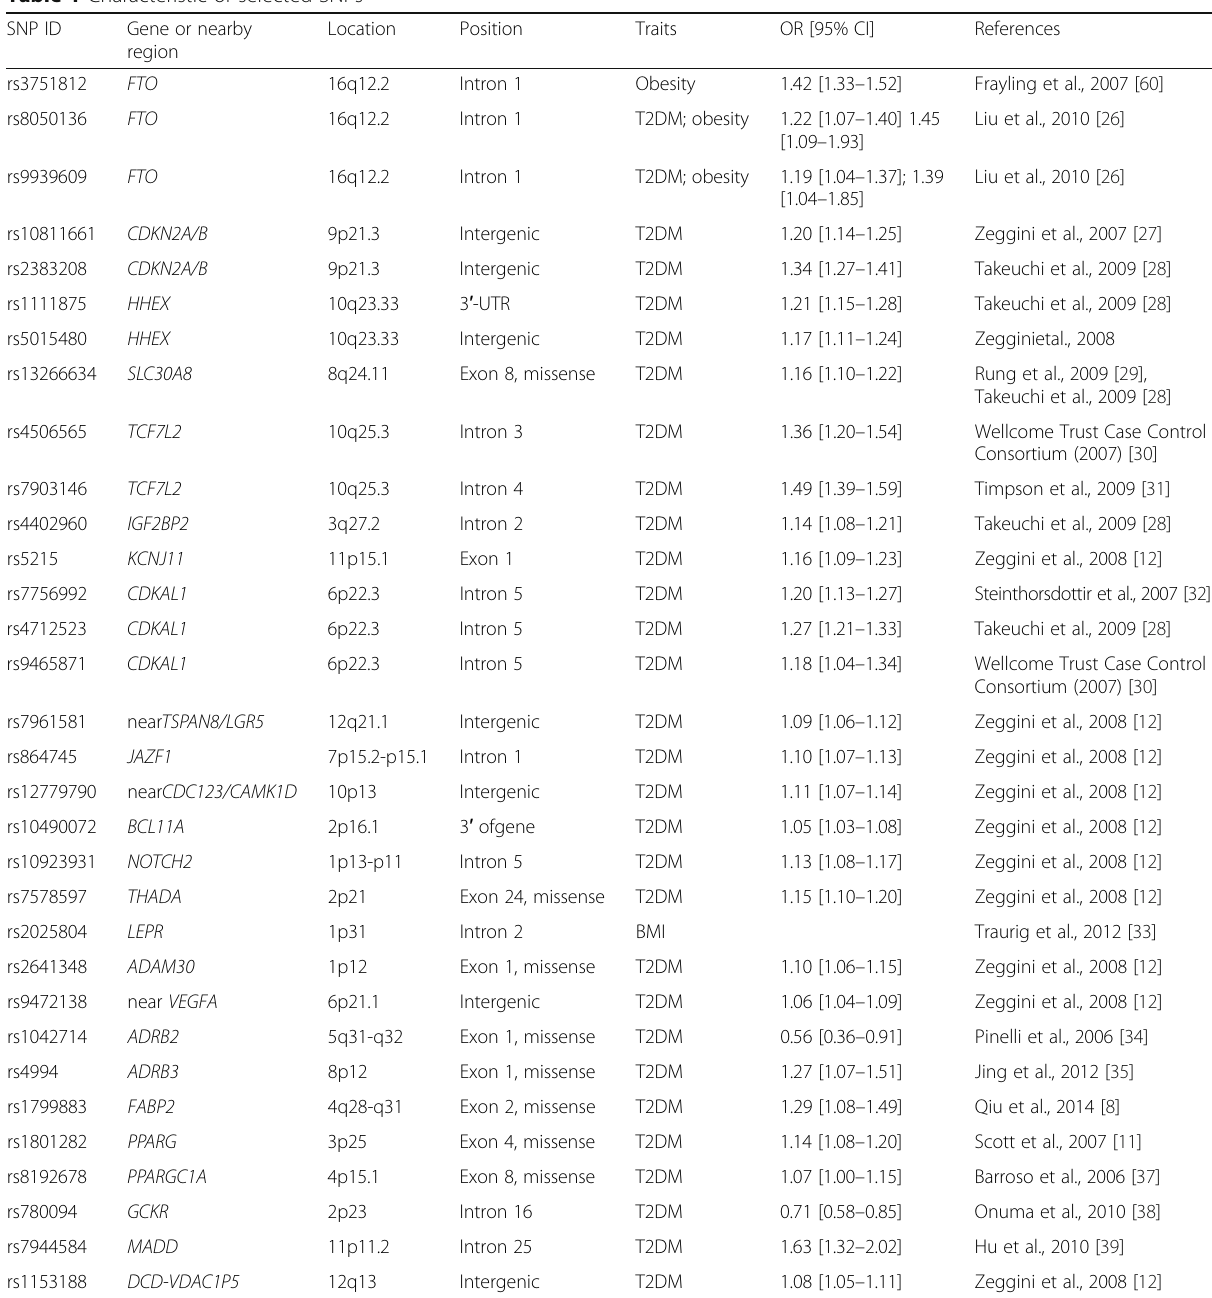
Table 1 Characteristic of selected